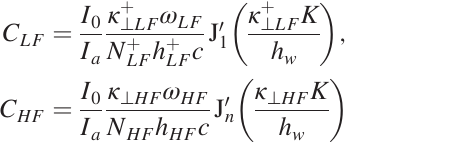
ffiffiffiffiffiffiffiffiffiffiffiffiffiffiffiffiffiffiffiffiffiffiffiffi p ω 2 =c 2 − κ 2 i